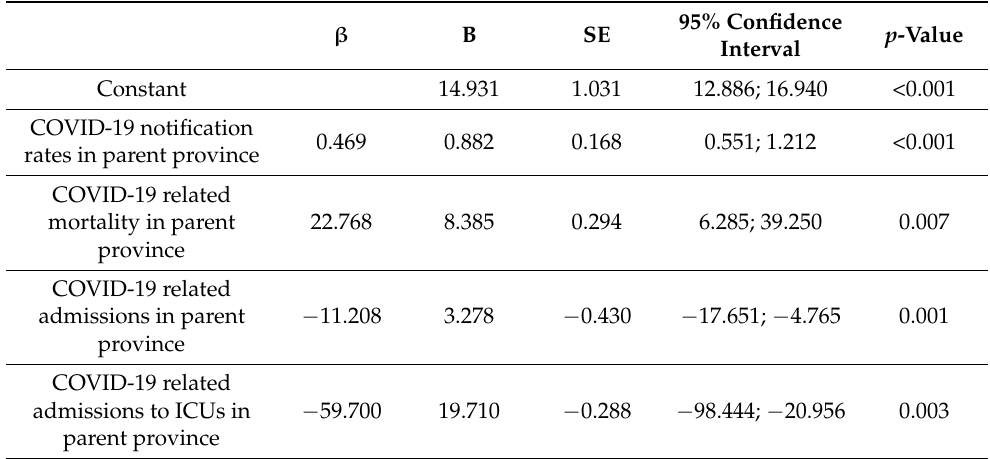
Table 5. Standardized regression analysis predicting the excess mortality rates for Italian small islands (R 2 = 0.109; adjusted R 2 = 0.100). Estimates were corrected for main demographic factors (i.e., share of individuals aged 60 or more, sex, annual income) both on Italian small islands and in parent provinces (Note: SE = standard error; β = standardized estimate; B = unstandardized estimate). β